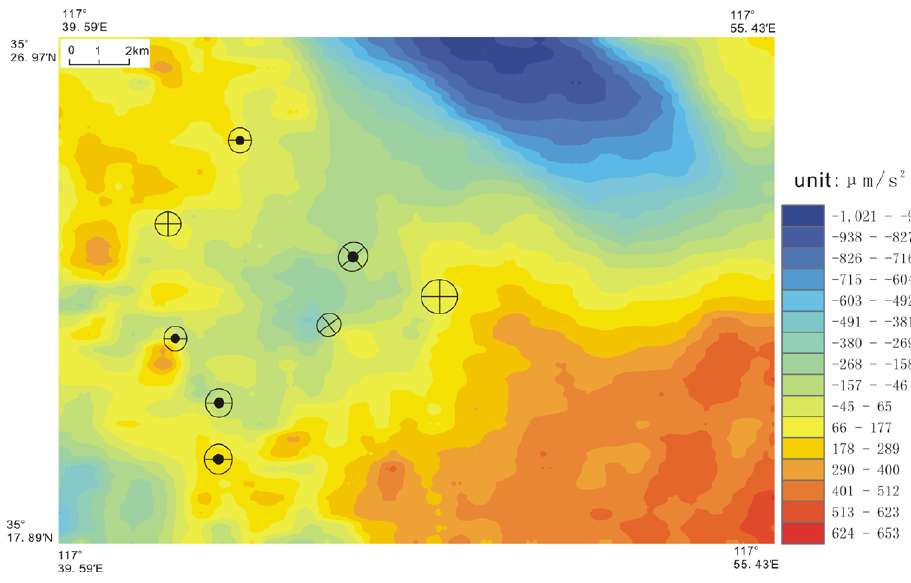
Fig. 2. The original gravity data image surveyed at scale 1:50000. The legends for the gold deposits see in Fig. 1.